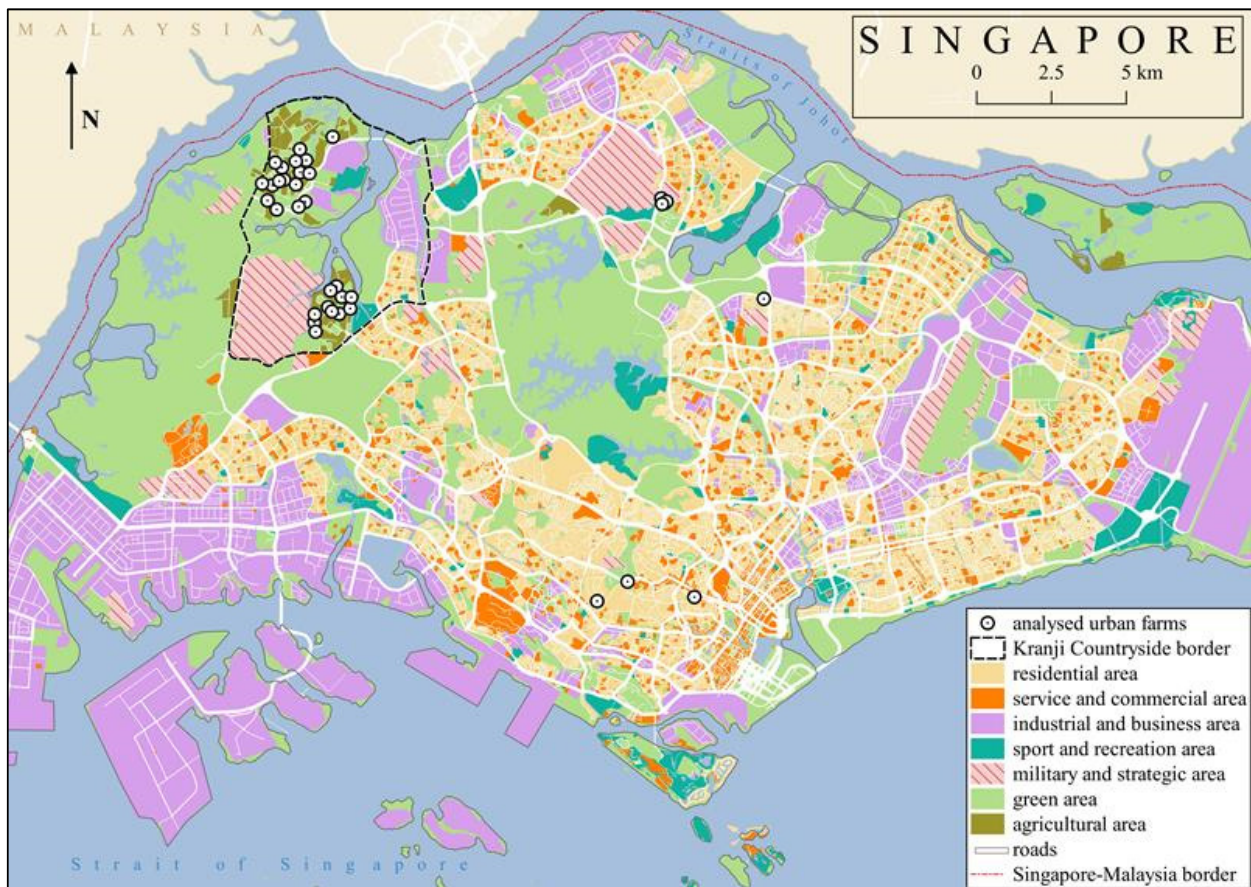
Figure 1. Land use and spatial distribution of urban farms in Singapore.